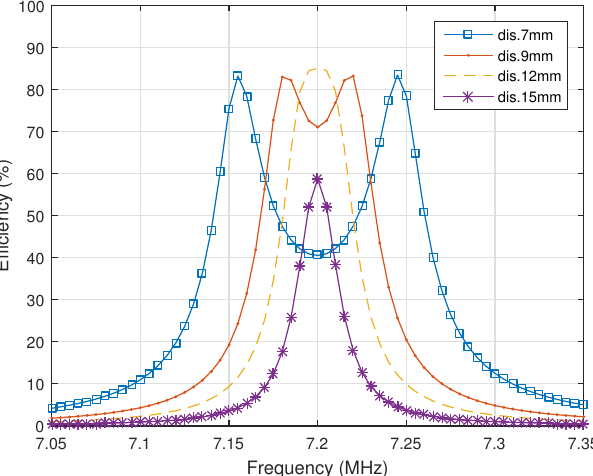
Figure 3. Maximum distance and frequency splitting phenomenon of the calculated